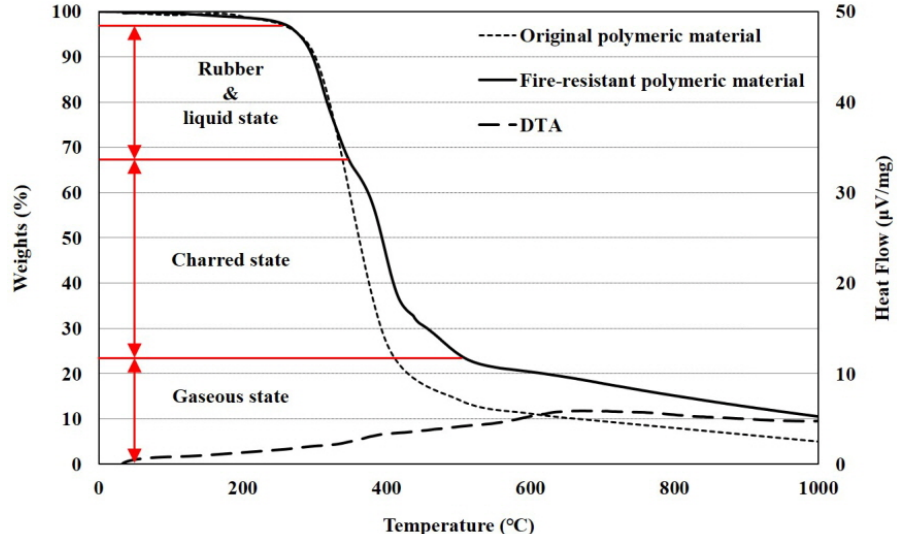
Figure 5. Thermal gravimetric analysis (TGA) and differential thermal analysis (DTA) results of original and fire-resistant polymeric materials.